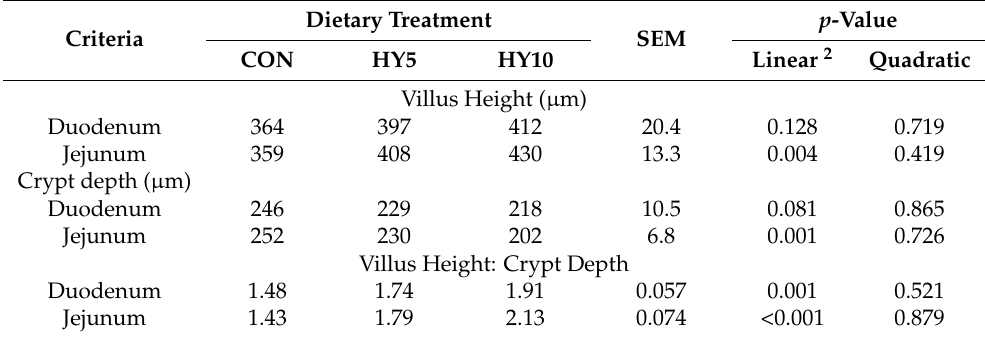
Table 4. Intestinal morphology of early weaned piglets fed HY-supplemented diet 1